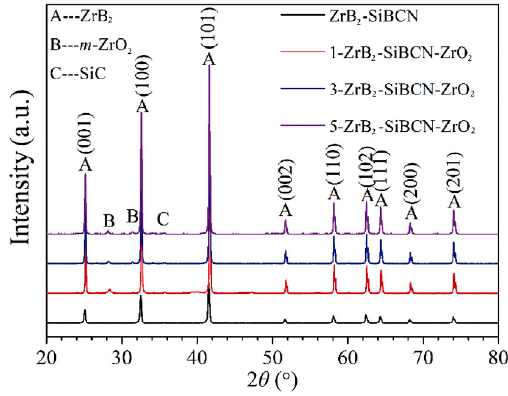
Fig. 1 XRD patterns of the obtained ZrB 2 –SiBCN ceramics with different content of ZrO 2 sintered at 1600 ℃ for 15 min.